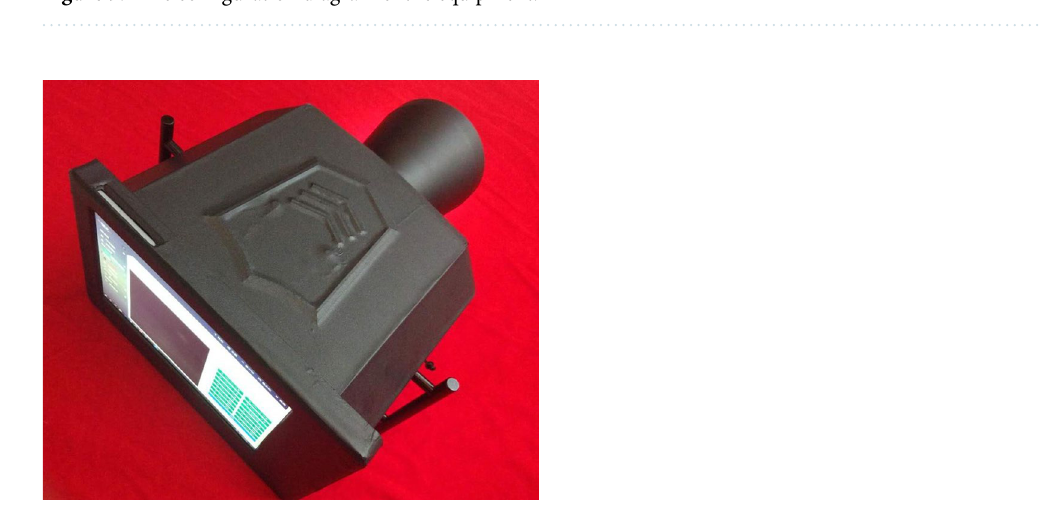
Figure 7. The configuration diagram of the equipment.